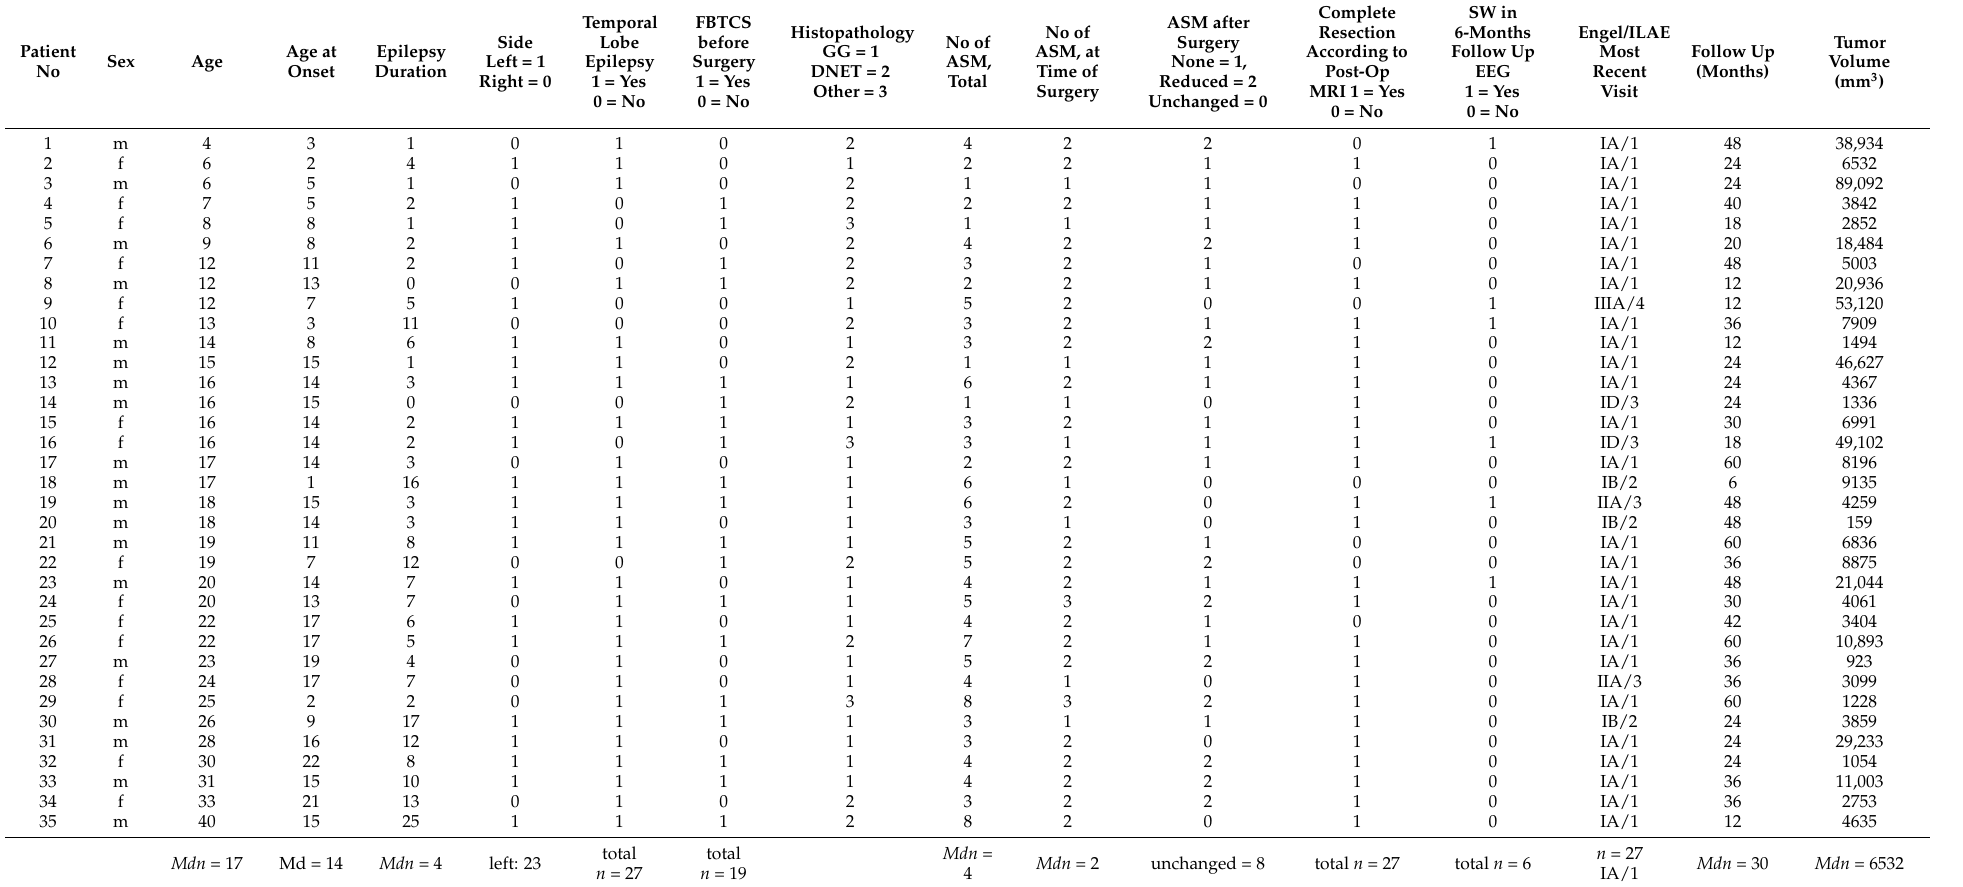
Table 1. Clinical characteristics and outcome of the patient cohort ( n =